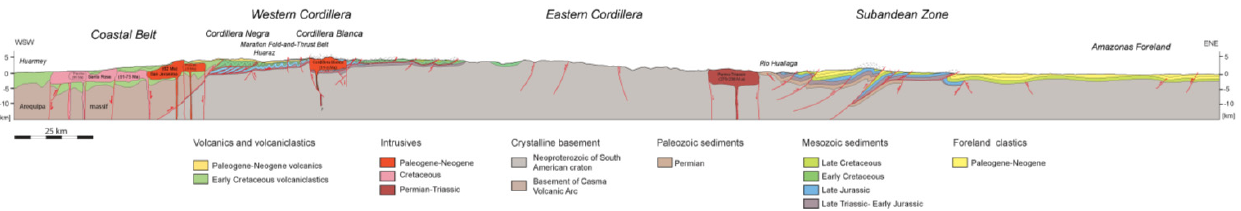
Figure 15. Northern Traverse: This balanced cross-section runs from the Pacific coast (Casma) to Huaraz into the Amazonas Foreland. The trace is shown in Figure 7. See text for discussion. An enlarged version of this figure is available in the supplementary material (Figure